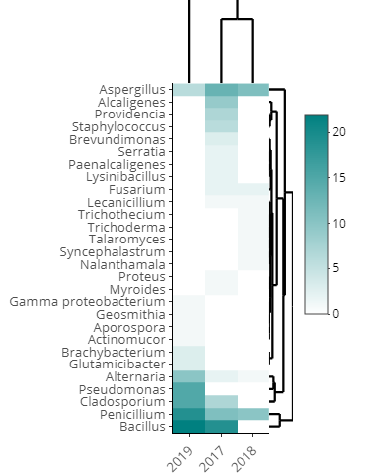
Figure 4. Taxonomic diversity according to the year of isolation. ( A ) Venn diagram comparing the genera isolated in 2017, 2018, and 2019. The list of genera is presented at the right of each diagram. ( B ) Heat map of isolated genera in 2017, 2018, and 2019. The row represents the tested isolate, and the column represents the year of isolation. The green color corresponds to the highest values, while the white color corresponds to the lowest ones.